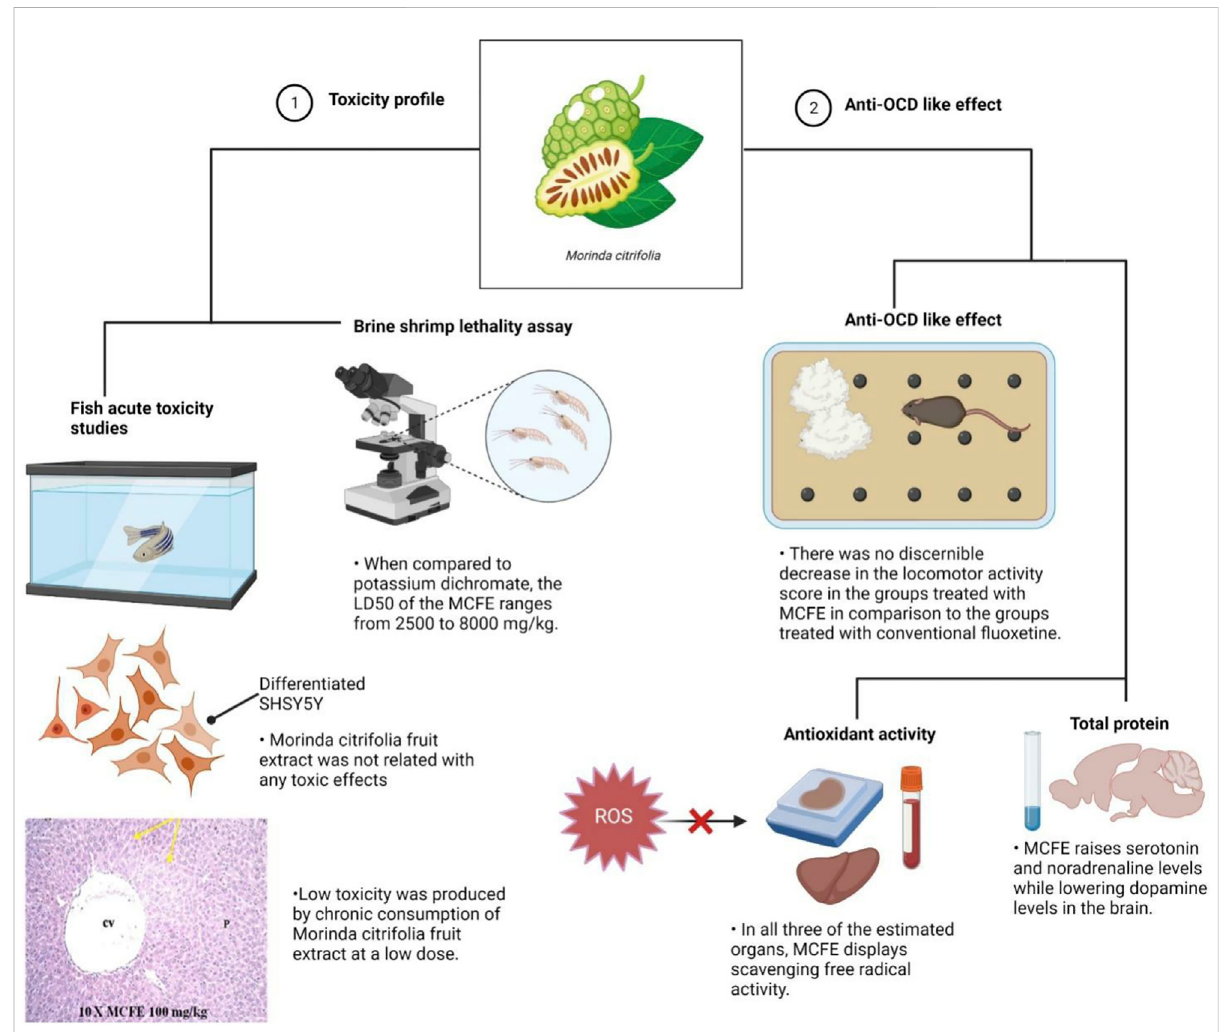
FIGURE 8 SchematicillustrationdepictedMCFEtoxicitypro fi leandanti-OCD-likeeffects.Asidefromitssigni fi cantneuroprotectiveproperties,theresults of the experiments conducted revealed a minimal toxicity pro fi le of the extract in both in vitro and in vivo